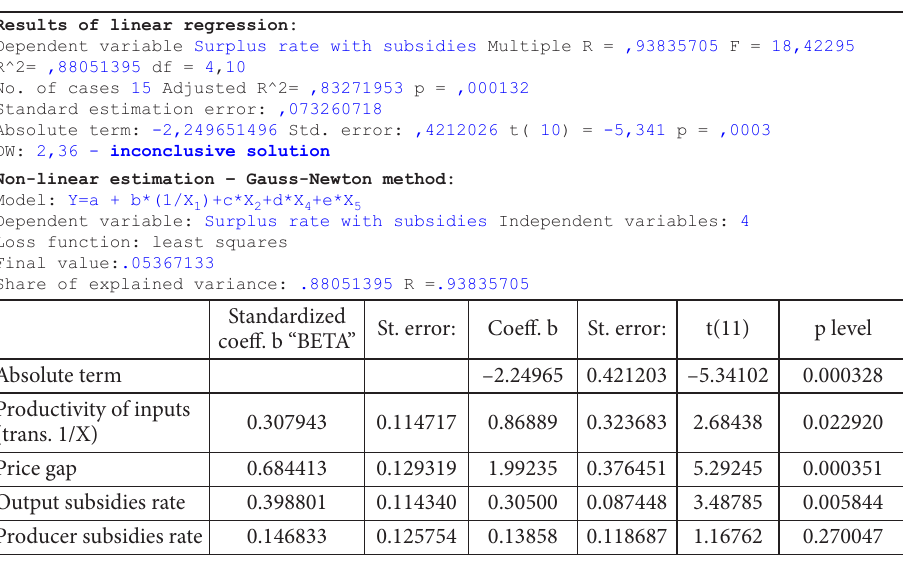
Table 7. Estimation of model 4 parameters